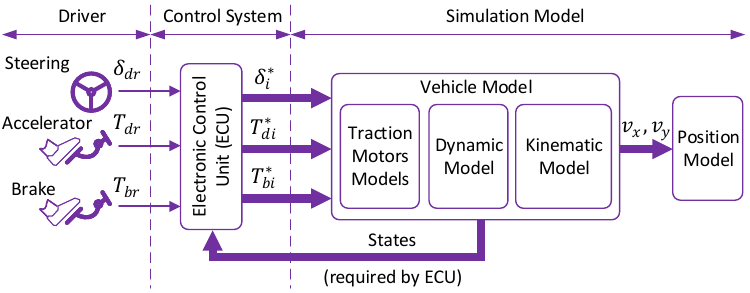
Figure 1. System Configuration for